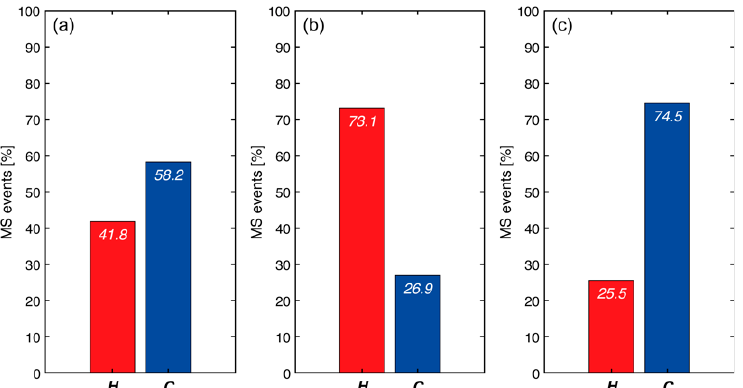
Figure 13. Percentage distribution of MS events during heating (in red) and cooling phases (in blue) for the whole monitoring period ( a ), the only winter storm of February 2018 ( b ), and for the entire monitoring period excluding the winter storm ( c ).